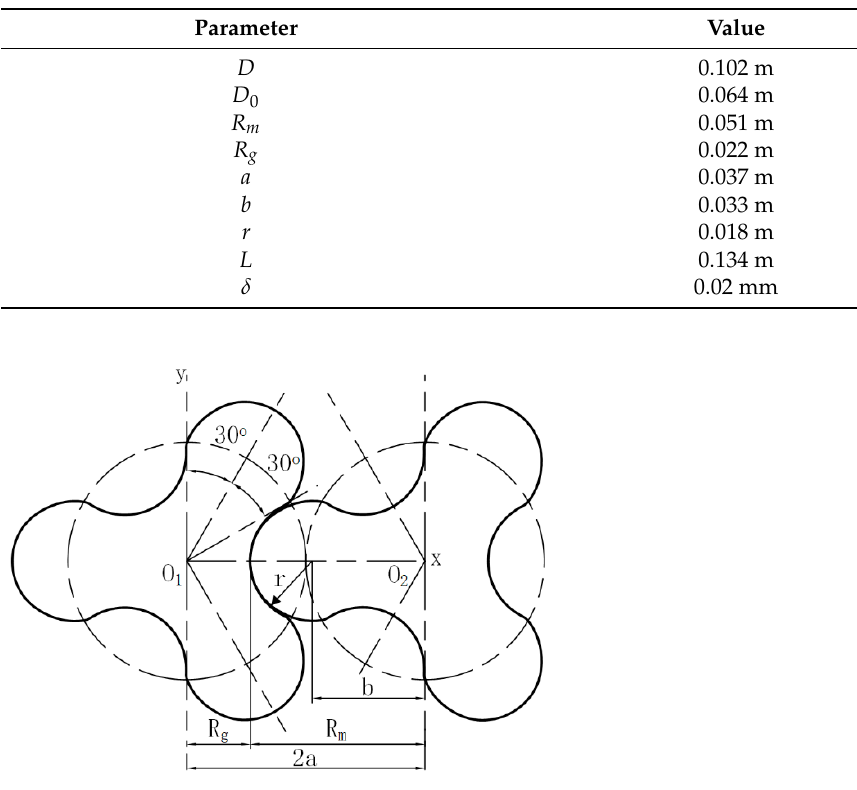
Figure 1. The rotor profile.